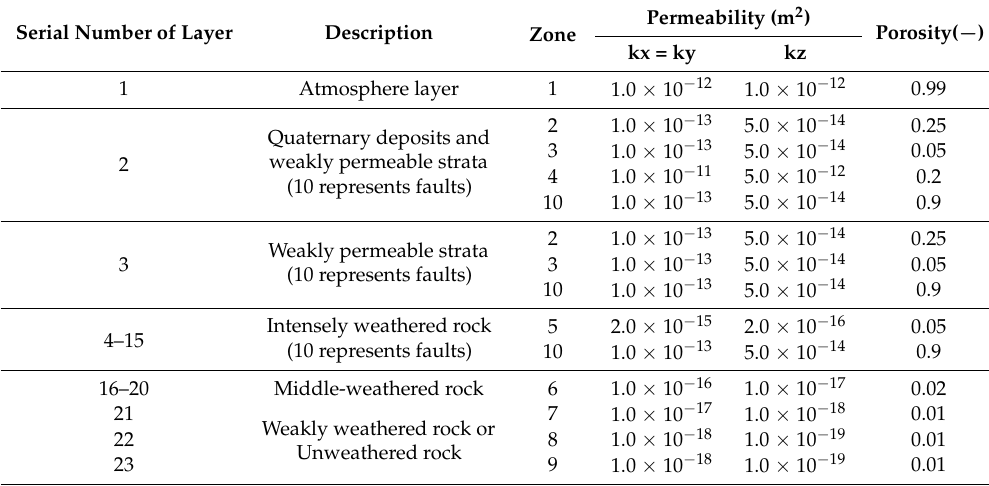
Figure 6. Lithology zoning map of the shallow layer: ( a ) zoning map of Layer 2; and ( b ) zoning map of Layer 3. The numbers are consistent with the Table 2. Table 2. List of the hydrogeology zones for the 23 model layers.